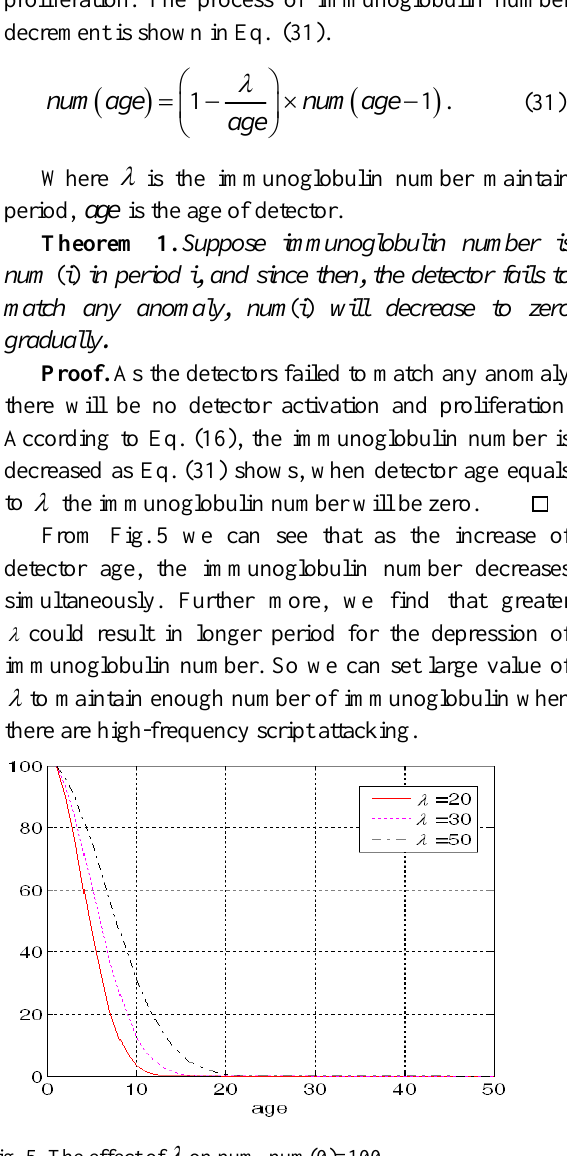
Fig. 5. The effect of λ on num,